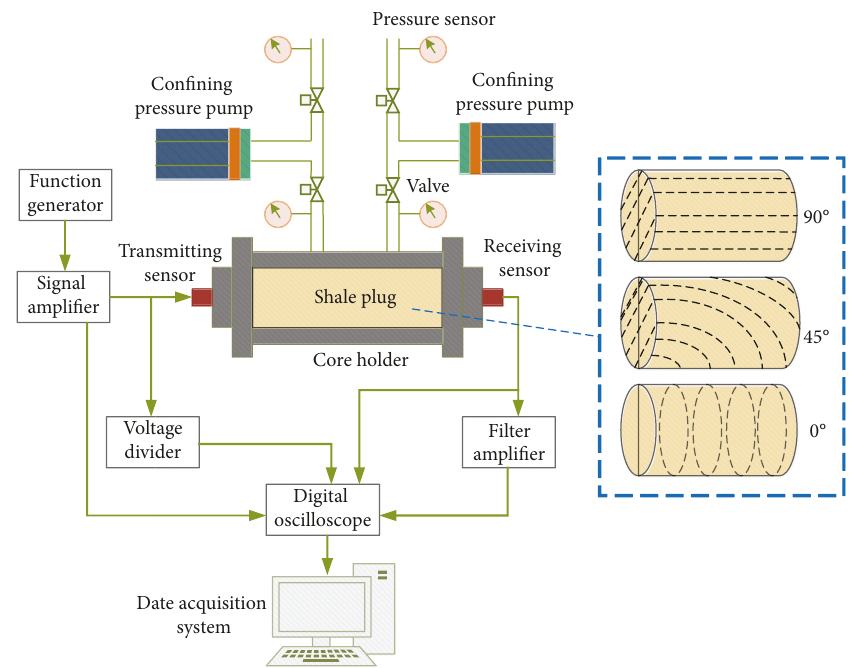
Figure 4: Schematic diagram of wave velocity test device in a high-pressure